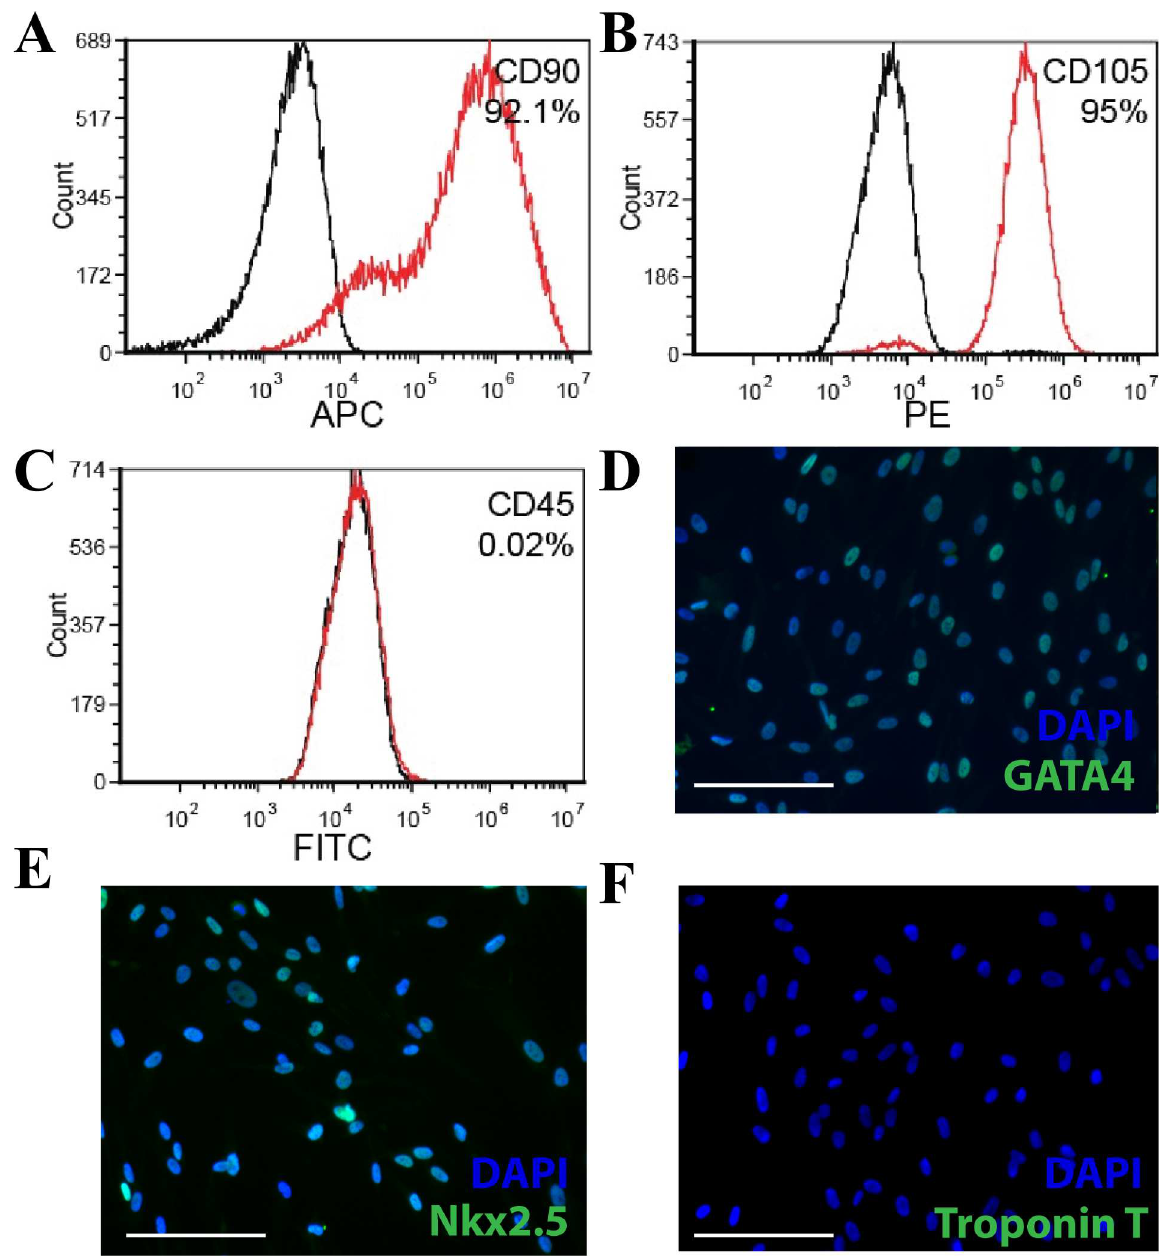
Fig 1. Characterization of human cardiosphere-derived cells (CDCs). (A-C) Representative fluorescence activated cell sorting (FACS) plots of CDCs stained with CD90, CD105 and CD45 (plotted in red) and their respective isotype controls (plotted in black). hCDCs express high levels of mesenchymal markers CD90 and CD105 and are negative for leukocyte common antigen marker, CD45. (D) hCDCs stain positive for cardiac transcription factor GATA4 and Nkx2.5 and negative for TroponinT. Scale bar 200 μ m.